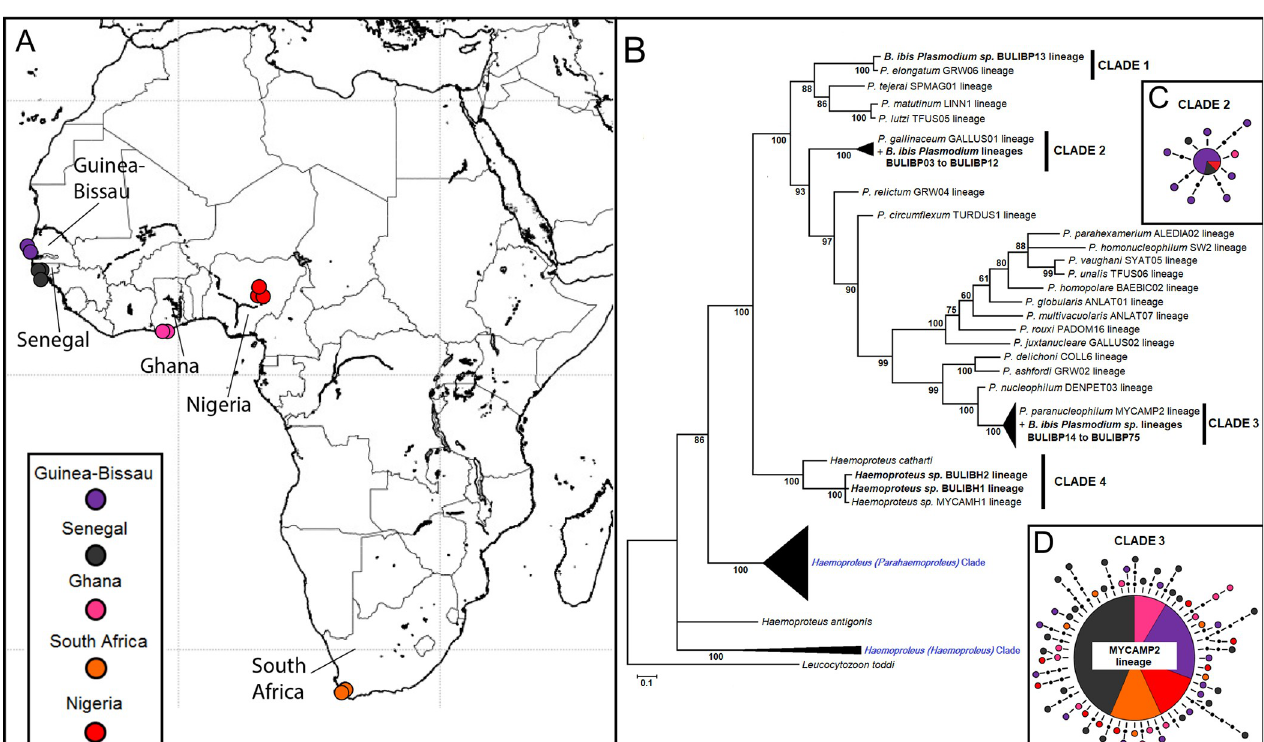
Fig 1. Location of sampling sites in Africa and phylogenetic identification of haemosporidian lineages. A) Map of Africa with sites where blood was sampled from cattle egret nestlings. B) Phylogenetic tree defined by Bayesian method showing lineages identified in this study and lineages from literature and database. C) Haplotype network corresponding to Plasmodium spp. lineages from BULIBP3 to BULIP12 from clade 2. D) Haplotype network showing genetic relationships among Plasmodium spp. lineages from BULIBP14 to BULIBP75 from clade 3.